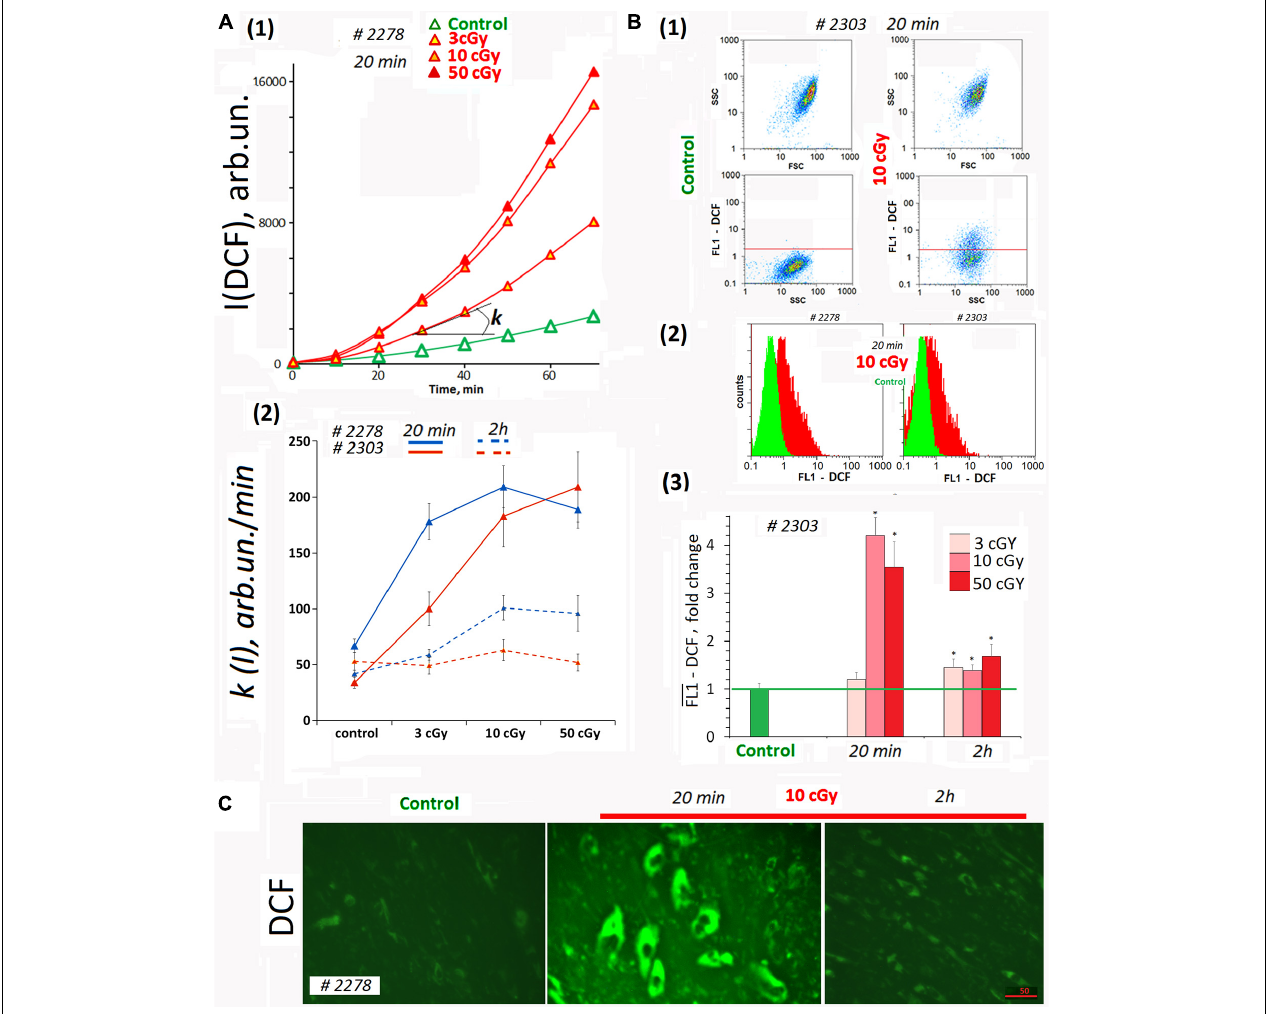
FIGURE 2 | ROS levels in the irradiated cells. (A) Plate assay (FL-reader). The cells were analyzed using total fluorescence assay in the 96-well plate format at λ ex = 490 nm and λ em = 524 nm. (1) Example of reaction rate constant determination for DCF formation when DCFH reacts with ROS. Cells were irradiated with doses of 3, 10, and 50 cGy and were cultivated for 20 min. The cultivation environment was replaced by 5 µ M H 2 DCFH-DA in PBS solution and a fluorescence intensity increase was detected. The slope of the line is the reaction rate constant for DCF formation [ k(I) ]. (2) The constants k(I) of the rate of DCF formation in MSCs #2278 and #2303. The H 2 DCFH-DA reagent was added 20 min or 2 h after irradiation. Average values and SD are given for three experiments. In each experiment, cells were analyzed in four wells of the plate. (B) FACS. (1) Plots: SSC versus FSC and FL1-DCF versus SSC. (2) The distribution of MSCs #2278 and #2303 (10 cGy, 20 min after LDIR) with varying DCF signal. (3) Median signals for FL1–DCF. Signals are normalized to control values. Average values and SD are given for three experiments. * p < 0.001 ( U test). (C) Fluorescence microscopy. Before the treatment with LDIR, cells were grown for 48 h in slide flasks. Twenty minutes or 2 h